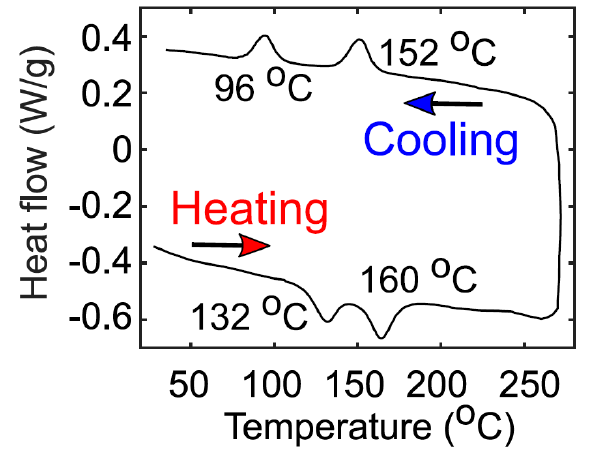
Figure 2. Differential scanning calorimetry of pristine NiPc (cid:2874) powder for both heating (endothermic) Figure 2. Di ff erential scanning calorimetry of pristine NiPc 6 powder for both heating (endothermic) and cooling (exothermic). The powder is collected from a spin-coated sample. and cooling (exothermic). The powder is collected from a spin-coated